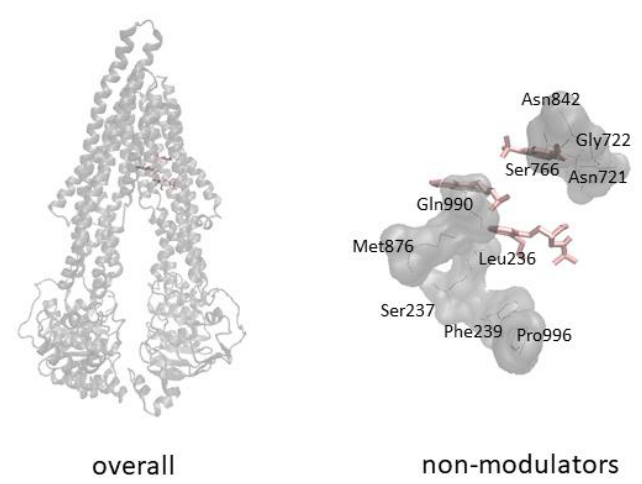
Figure 3. Molecular docking results for selected non-modulators (pink).